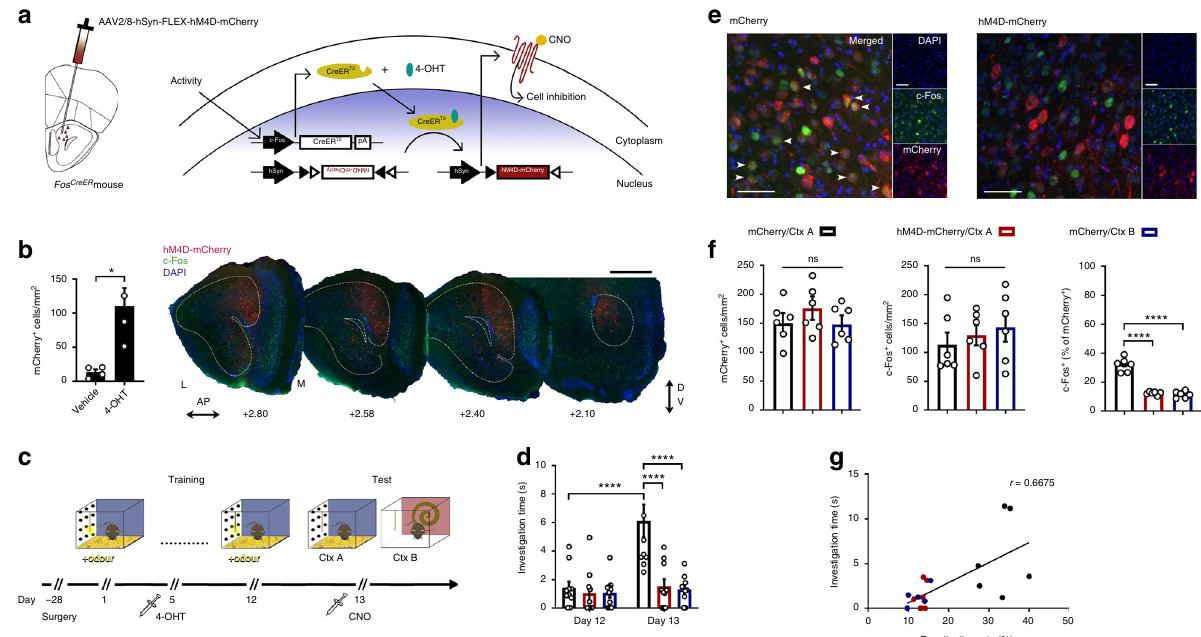
Fig. 1 Silencing a context-speci fi c odour memory. a Method for activity-dependent labelling and cellular inhibition using hM4D-mCherry. b Injections of 4- OHT induces AAV-mediated gene expression restricted to the medial AON as seen in representative coronal sections of a Fos CreER mouse [each group, n = 4 mice, two-tailed independent-samples t -test, t (6) = 3.549, * P = 0.0121). Anterior/Posterior (AP); Dorsal/Ventral (DV). Coordinates are relative to bregma. Scale bar represents 500 µ m. c Behavioural protocol for tagging and inhibiting context-driven odour engrams. Context (Ctx). d